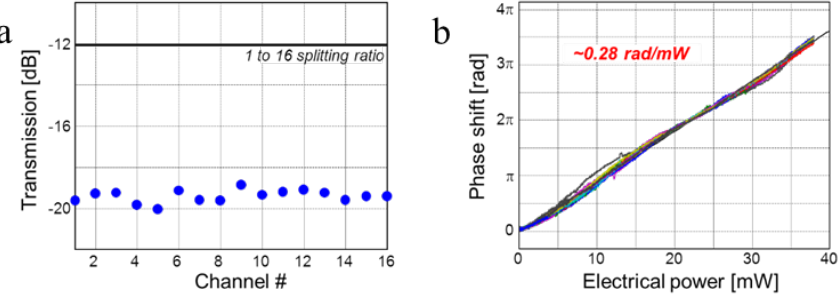
Figure 9. ( a ) Fibre-to-fibre transmission of the 16 channels; ( b ) Phase modulation response for the 16 channels (superposed colored lines).